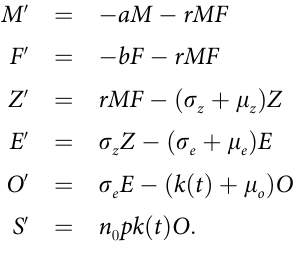
Table 1. Parameter values for the underlying within-vector model. All values, apart from G 0 and d , were obtained from Teboh-Ewungkem et al. [15]. G 0 was varied. d was obtainedfrom Teboh-Ewungkem et al. [16]. Symbol Description Default value G 0 number of gametocytes in blood meal {150, 200, ... , 450} m percentage of gametocytes that are male 0.25 ν number of female gametes per female gametocyte 1 ρ number of male gametes per male gametocytes 8 α fraction of male gametes that are viable 0.39 β fraction of female gametes that are viable 1 a failure rate of male gametocytes (per day) 24/(20/60) b failure rate of female gametocytes (per day) 24/(25/60) r fertilization of male and female gametes (per parasite per day) 0.08 μ z death rate of zygotes (per day) 1 μ e death rate of ookinetes (per day) 1.4 μ o death rate of oocysts (per day) 0 σ z transformation rate of zygotes (per day) 24/19 σ e transformation rate of ookinetes (per day) 0.6 n 0 number of sporozoites per oocyst 3000 p proportion of sporozoites that make it to salivary gland 0.2 t 0 time to mature oocyst formation (days) 10 d rate mature oocysts release sporozoites (per